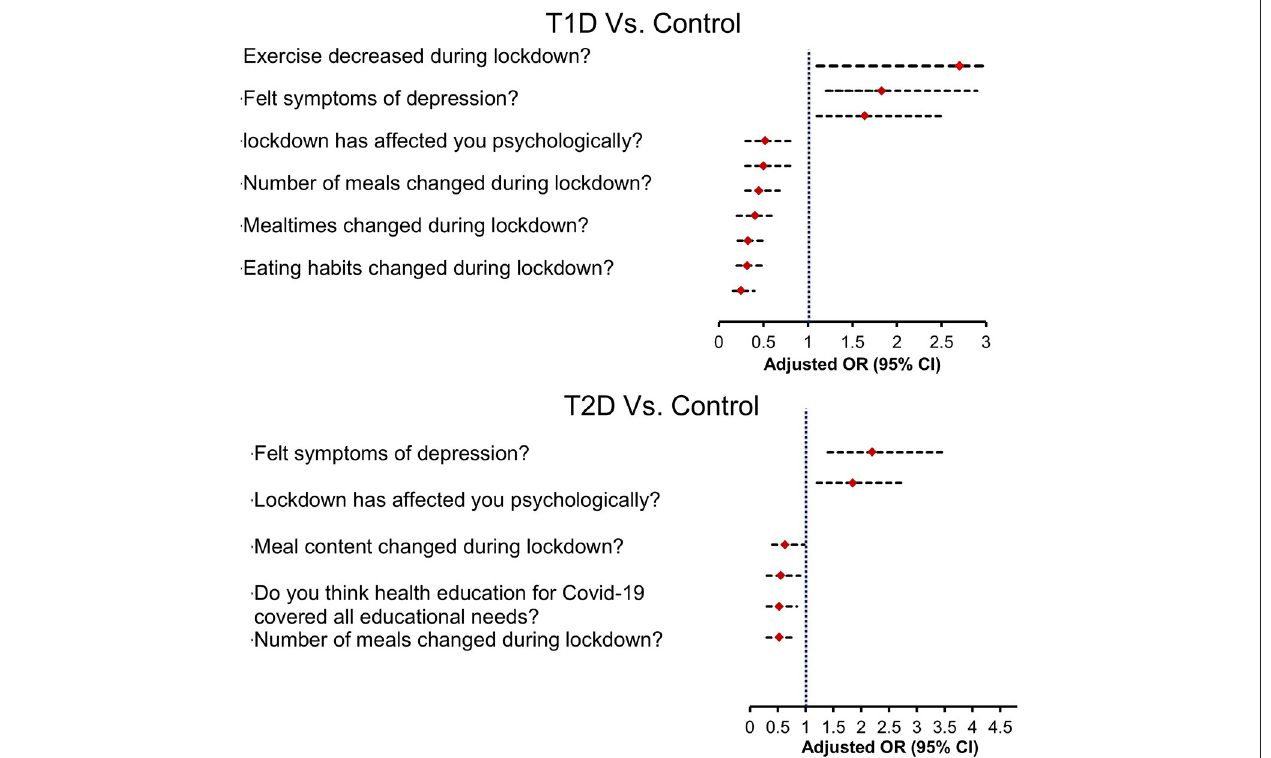
FIGURE 1 | Forest plot depicting adjusted odds of responses related to lifestyle changes in diabetes vs. control